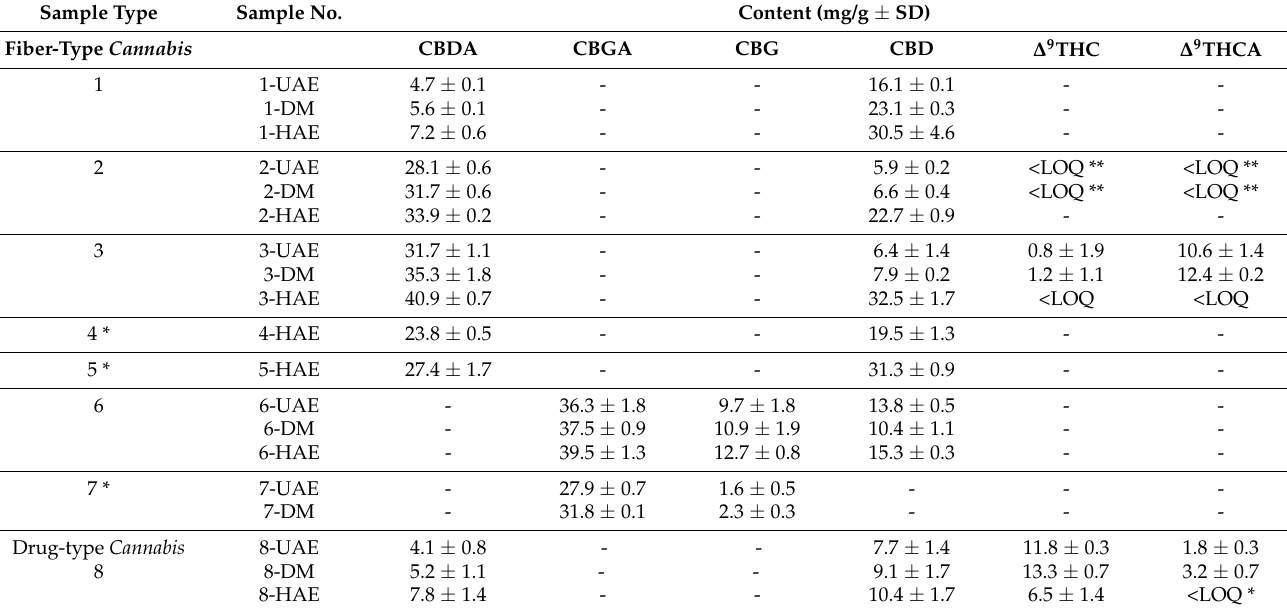
Table 5. Cannabinoids content in hemp inflorescences ethanolic